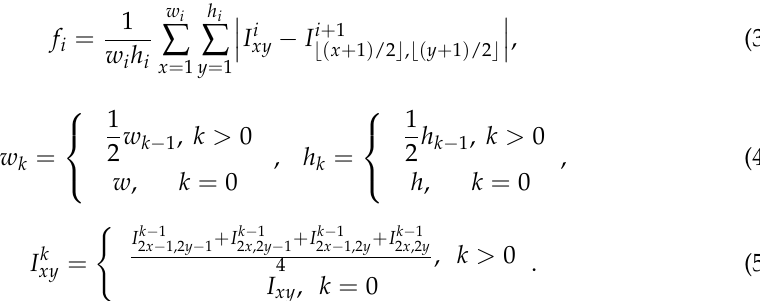
( b ) Figure 8. Examples of reference contours of Klyuchevskoy volcano, extracted for different values of γ : ( a ) γ = 0.5 — con- tours occurred in at least 50% of reference images; ( b ) γ = 1.0 — contours occurred in all reference images. The extracted reference contours are divided into internal and external ones. The ex- ternal contours are composed of line segments that have a maximum y-coordinate for point of intersection with vertical lines drawn with one pixel distance. The rest of the con- tours are considered internal. This separation allows us to correctly analyse images taken, for example, in conditions of sunlight, when only the general outline of the volcano is visible. In this case, analysis on a common set of contours will result in an underestimated visibility, while the outer contours of the volcano will be fully visible. The visibility estimate contours for the tested image is calculated by the